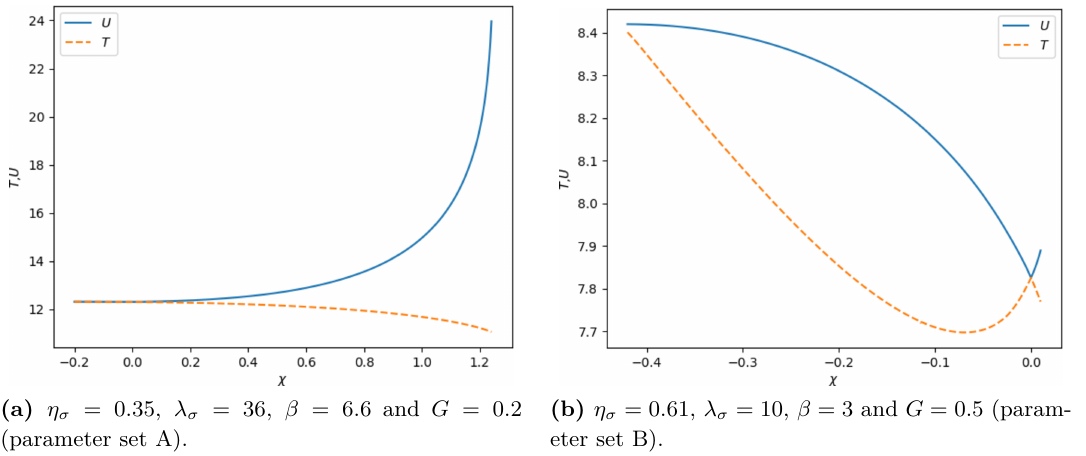
Figure 5 . The tension and energy per unit length of string as a function of χ . The functions converge at small χ because there is no condensation onto the string, while at χ = 0 they are equal and